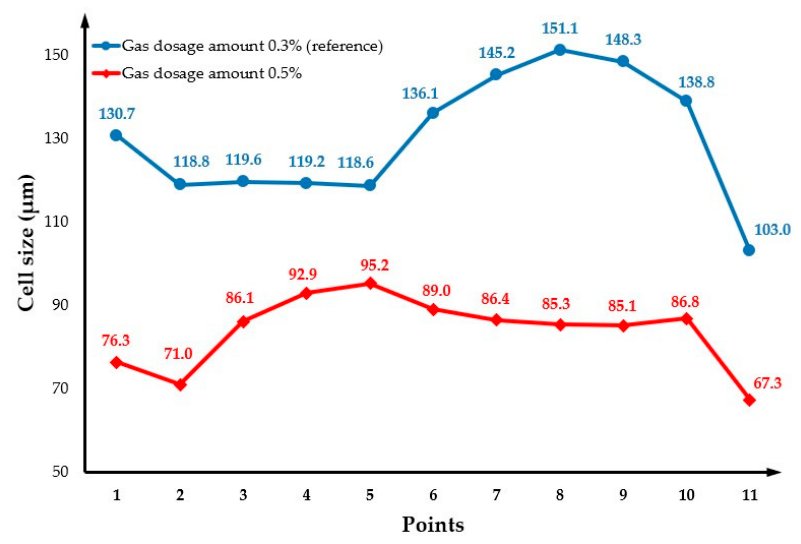
Figure 10. Melt front time when the gas dosage amount is 0.1%.